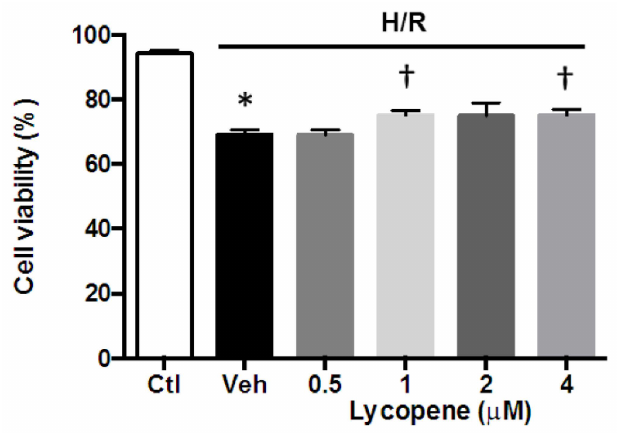
Figure 2. Effect of lycopene on HL-1 cardiomyocytes viability during in vitro hypoxia/reoxygenation (H/R). HL-1 cells were subjected to 2 h of hypoxia, then treated with 0.5, 1, 2, 4 µ M lycopene or vehicle alone during 2 h of reoxygenation. Controls were exposed normaxia throughout the experiment. Cell viability was assessed by trypan blue exclusion. Values are means ˘ SEM from three independent experiments, * p < 0.01 vs. Ctl, † p < 0.01 vs.